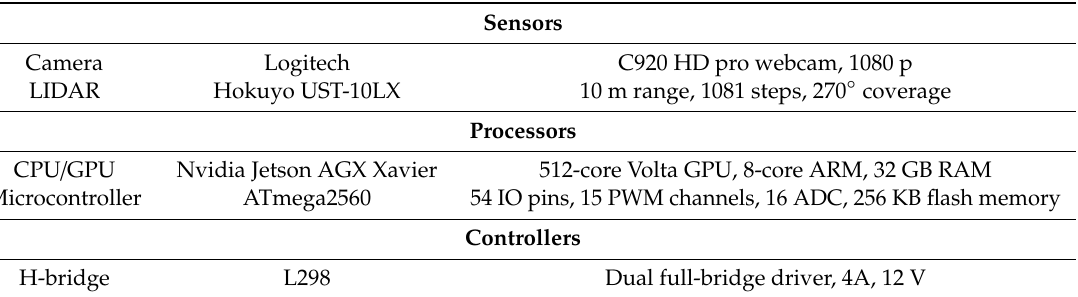
Table 4. Sensors, processors, and control